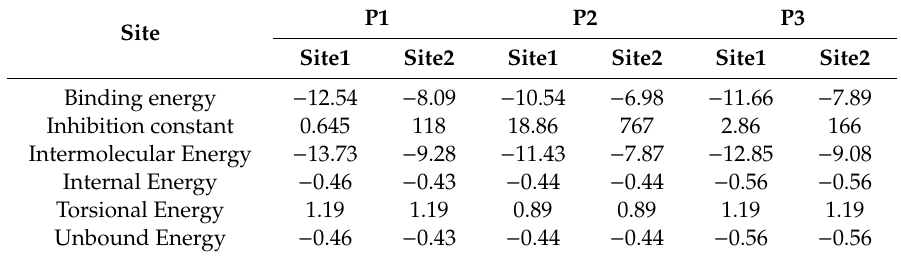
Table 1. Energy parameters (in kcal / mol) and inhibition constant (in nM) for P1, P2, and P3 in various binding sites in β -amyloid.